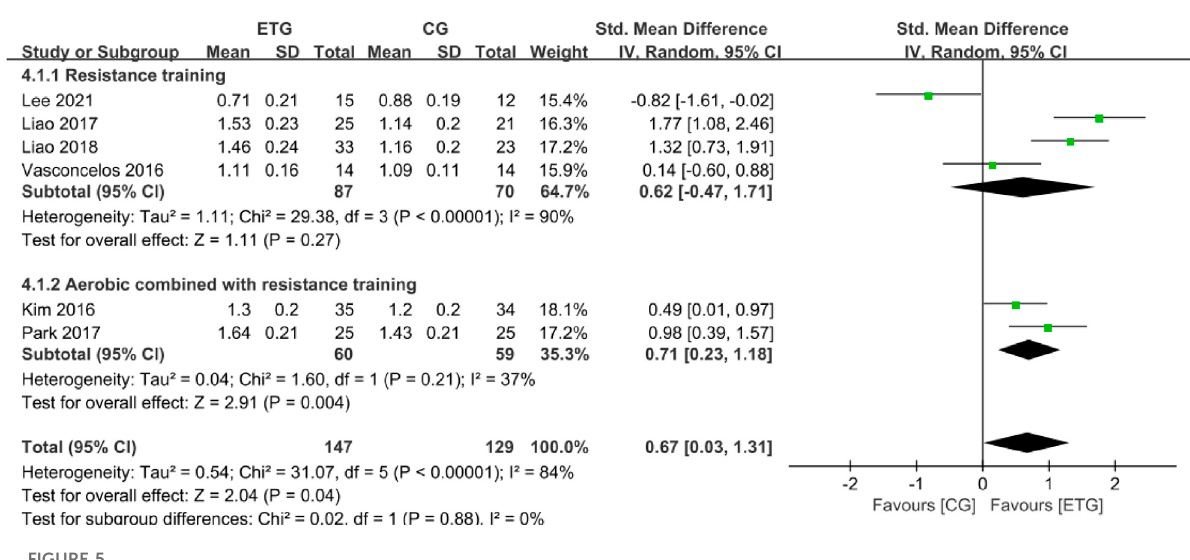
FIGURE 5 Forestplotsofthecomparisonoftheexercisetraininggroup(ETG)versusthecontrolgroup(CG)ongaitspeed(GS);CI,con fi denceinterval;SD, standard